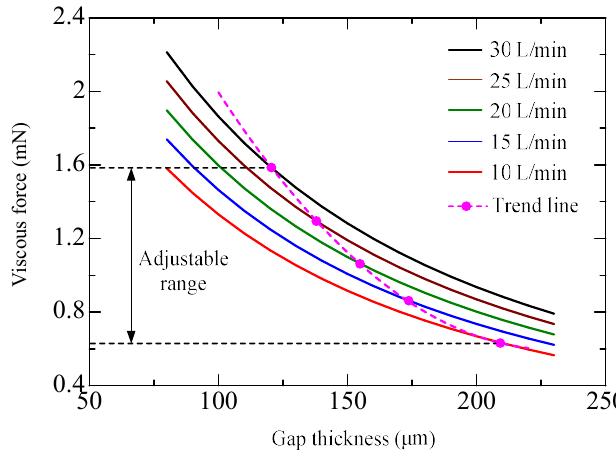
Figure 9. Calculated viscous force versus gap thickness.